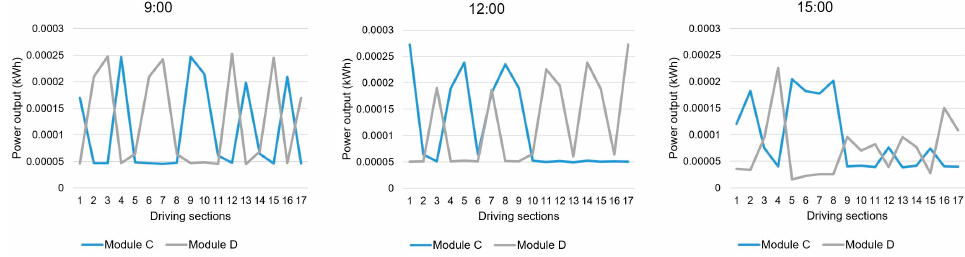
Figure 7. Graphs of the PV potential of the driving sections between modules C and D.